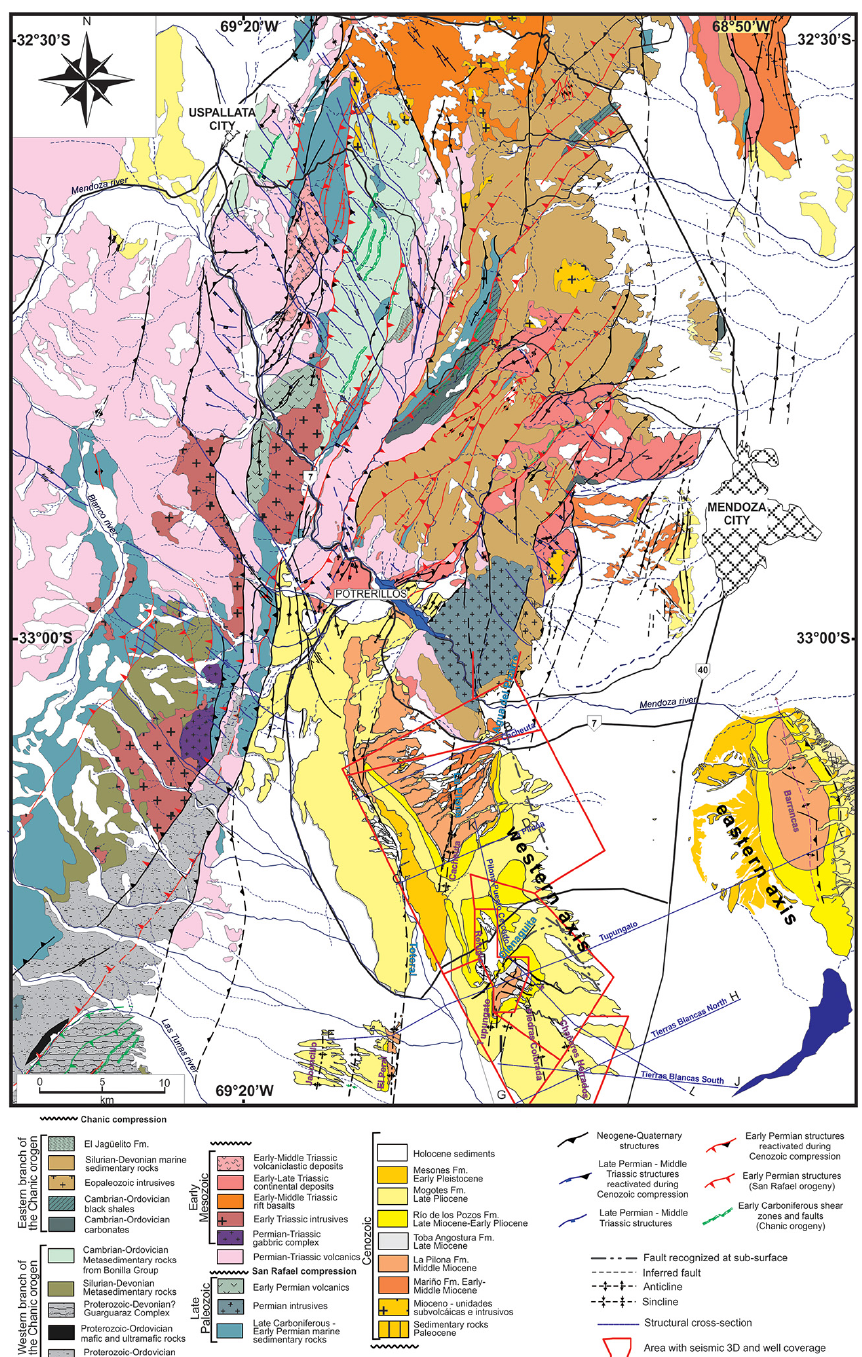
Figure 2. Geological-structural map of the study area (32 ◦ 30 (cid:48) –33 ◦ 20 (cid:48) S), showing principal structures recognized at outcrops (different colors in the structural traces represent different deformational phases), modified from Giambiagi et al. (2014). Areas of the Cacheuta, El Peral, Tupungato and Barrancas anticlines were mapped after Irigoyen et al. (2000), García and Casa (2015), Chiaramonte et al. (2000) and Stahlschmidt (1985), respectively. The Cuyo Basin is expressed at surface by two ranges trending NNW, the western and eastern axes, exposing only the Miocene–Pleistocene sedimentary rocks, except in the northernmost sector of the western axis, where basement rocks and Triassic rift units are exposed (Potrerillos area). Red lines show the oil field areas under study.